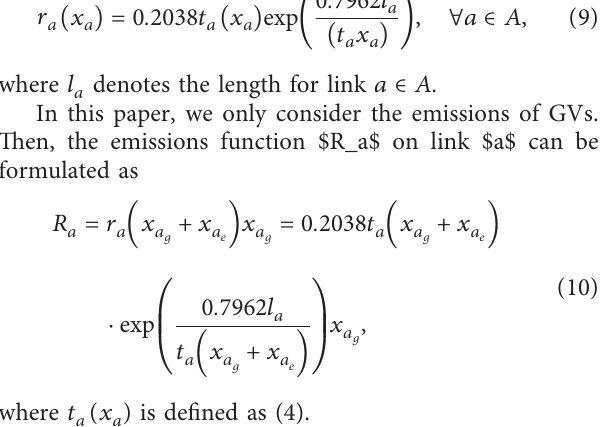
( x )} . (a) Different value of α . (b) Different value of β a a